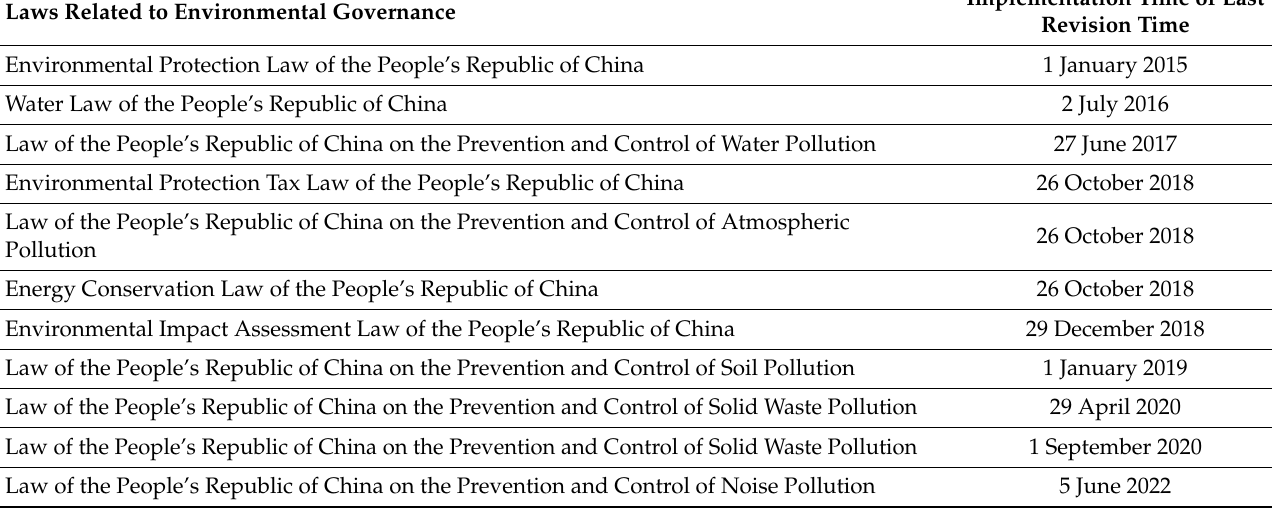
Table A1. The environmental regulation laws in China after